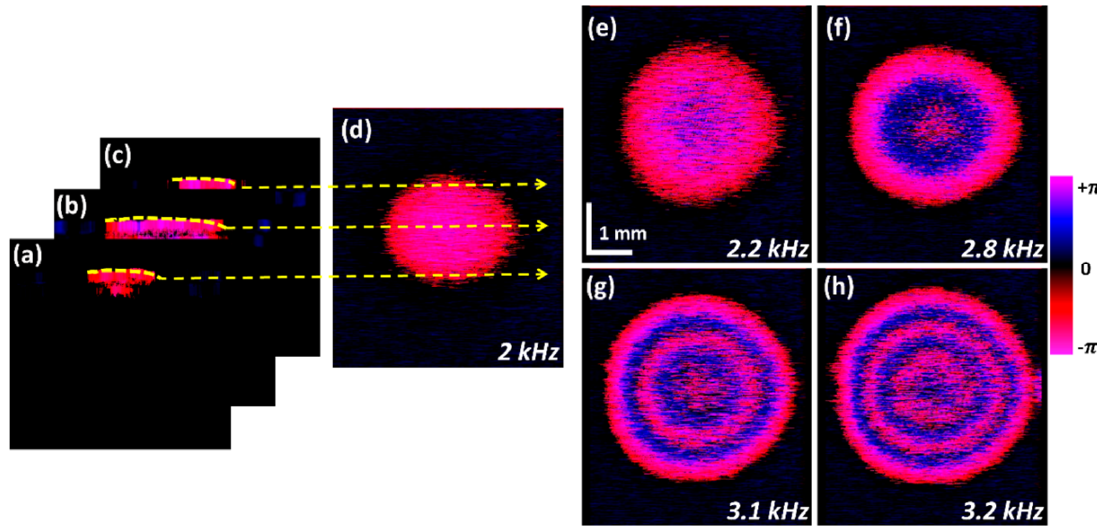
Figure 2. Process to obtain 2D-ODT enface image representations. ( a – d ) Process of 2D-ODT enface image extraction. ( a – c ) depict acquisition of uppermost cross-sectional information. ( d ) Total ODT-enface representation at 2 kHz frequency. ( e – h ) show the ODT enface image variations according at 2.2 kHz, 2.8 kHz, 3.1 kHz and 3.2 kHz frequencies, respectively; ODT, optical Doppler tomography. Reprinted with permission from Ref. [46] .